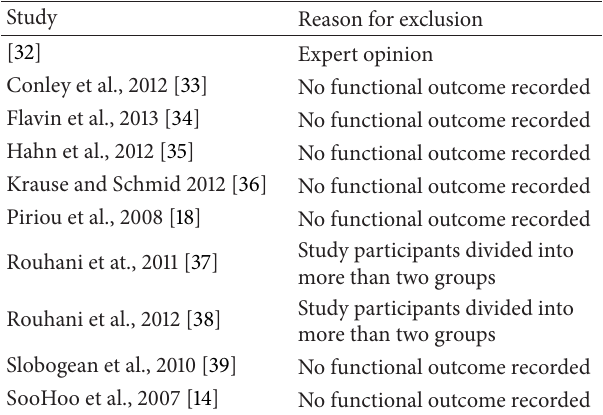
Table 4: Reason for exclusion of studies after full paper